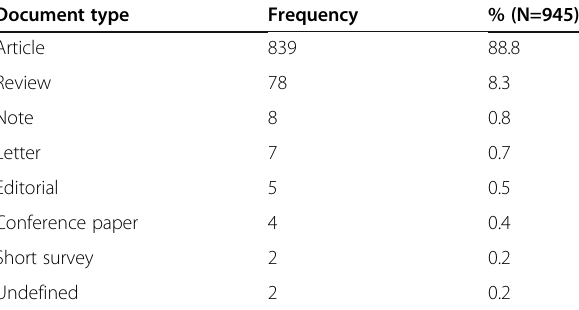
Table 1 Types of retrieved documents on mental health literacy